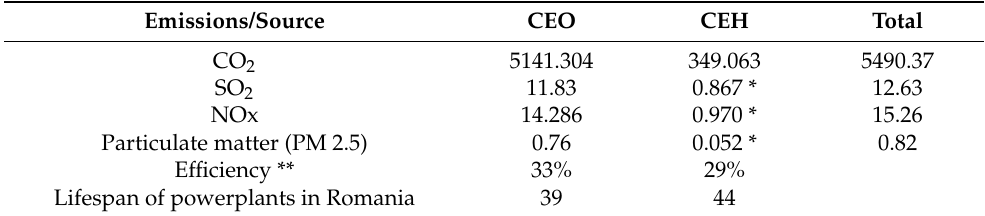
Table 1. Greenhouse gas emissions generated by Complexul Energetic Oltenia (CEO) and Com-